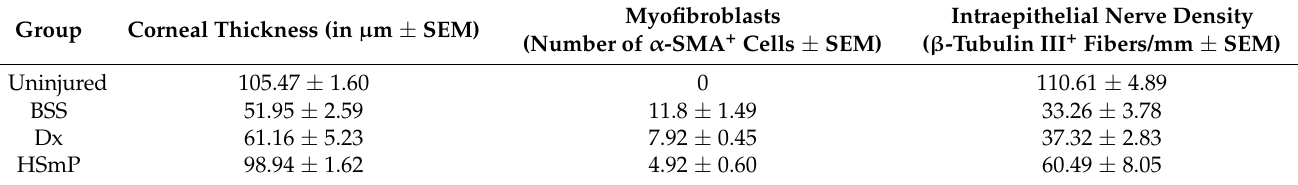
Table 1. Measurements of histomorphometric parameters at 7